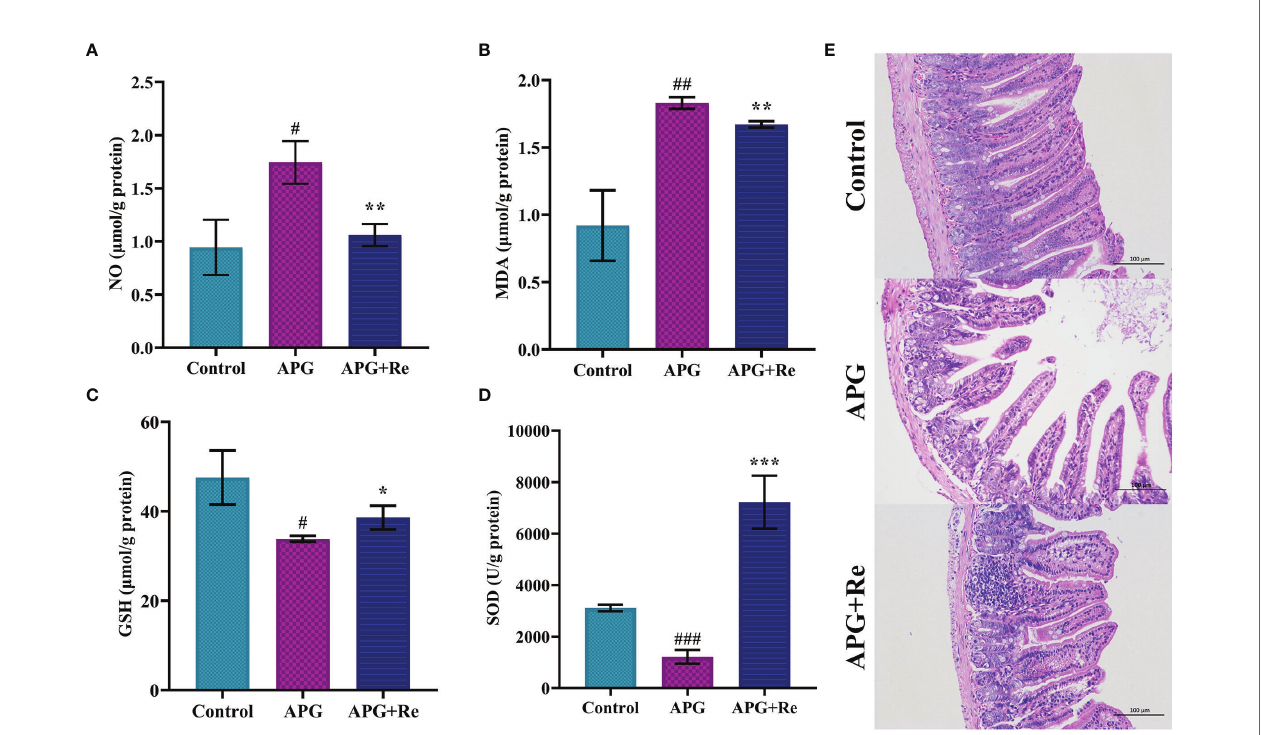
FIGURE 4 | Resveratrol mitigated damage from oxidative stress in the mice with celiac disease. (A) NO content in jejunal tissue. (B) MDA content in jejunal tissue. (C) GSH content in jejunal tissue. (D) Enzymatic activity of SOD in jejunal tissue. (E) Intestine histological sections of jejunum stained with hematoxylin and eosin stain from mice. # Indicated statistically signi fi cant differences when compared to the control group. # P < 0.05; ## P < 0.01; ### P < 0.001. * Indicated statistically signi fi cant differences when compared to the APG group. *P < 0.05; **P < 0.01; ***P < 0.001. (E) are the fi elds of view at 200x